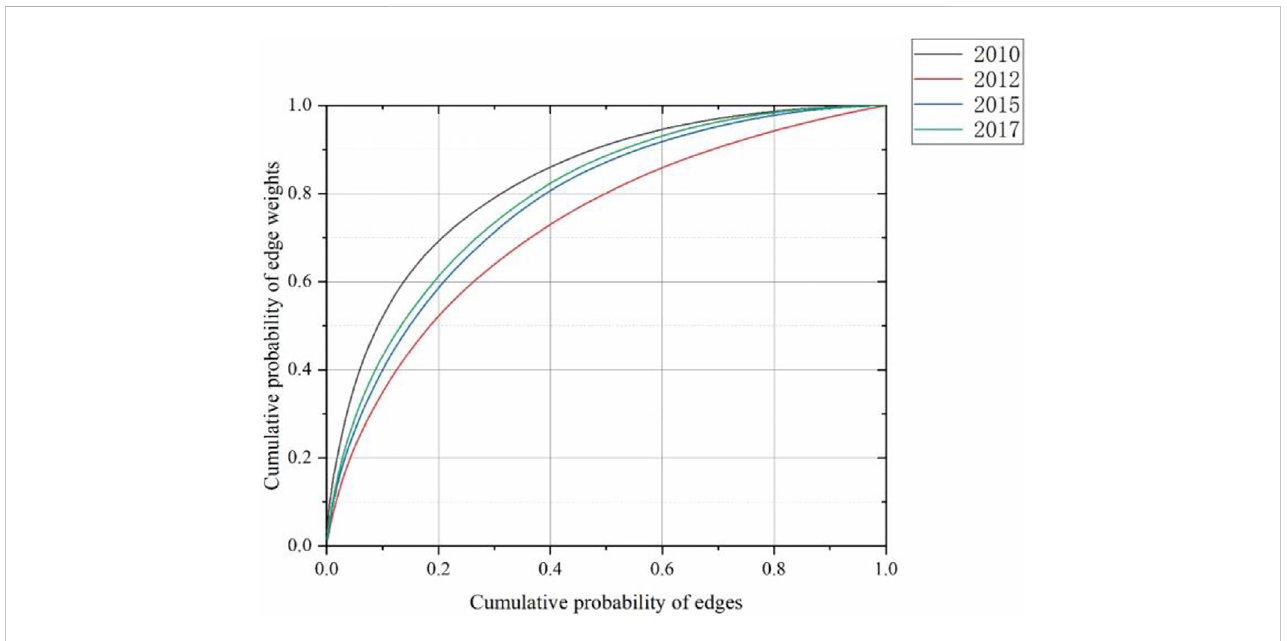
Cumulative probability distribution of edge